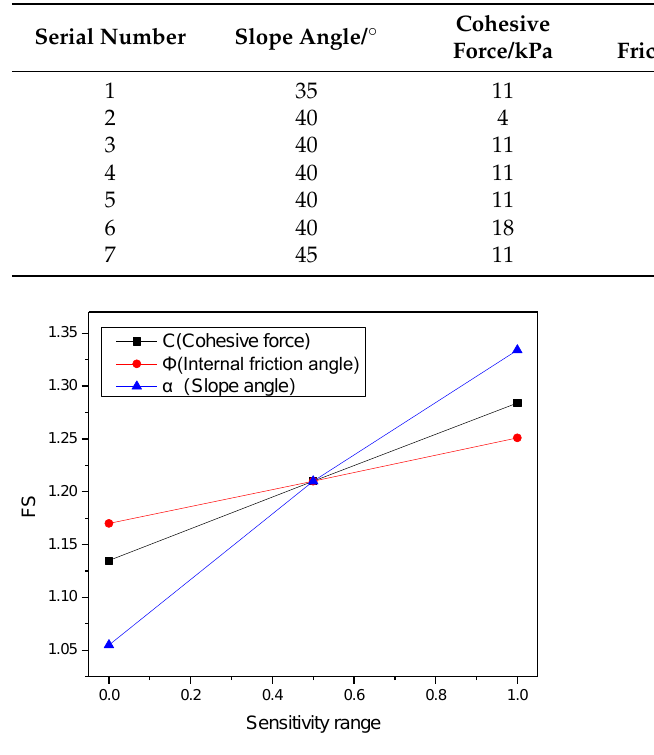
Figure 7. Sensitivity analysis curve.